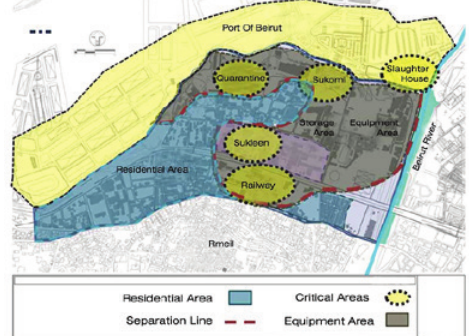
Figure 3. The impact of historical events on the constitution of the Mdawar